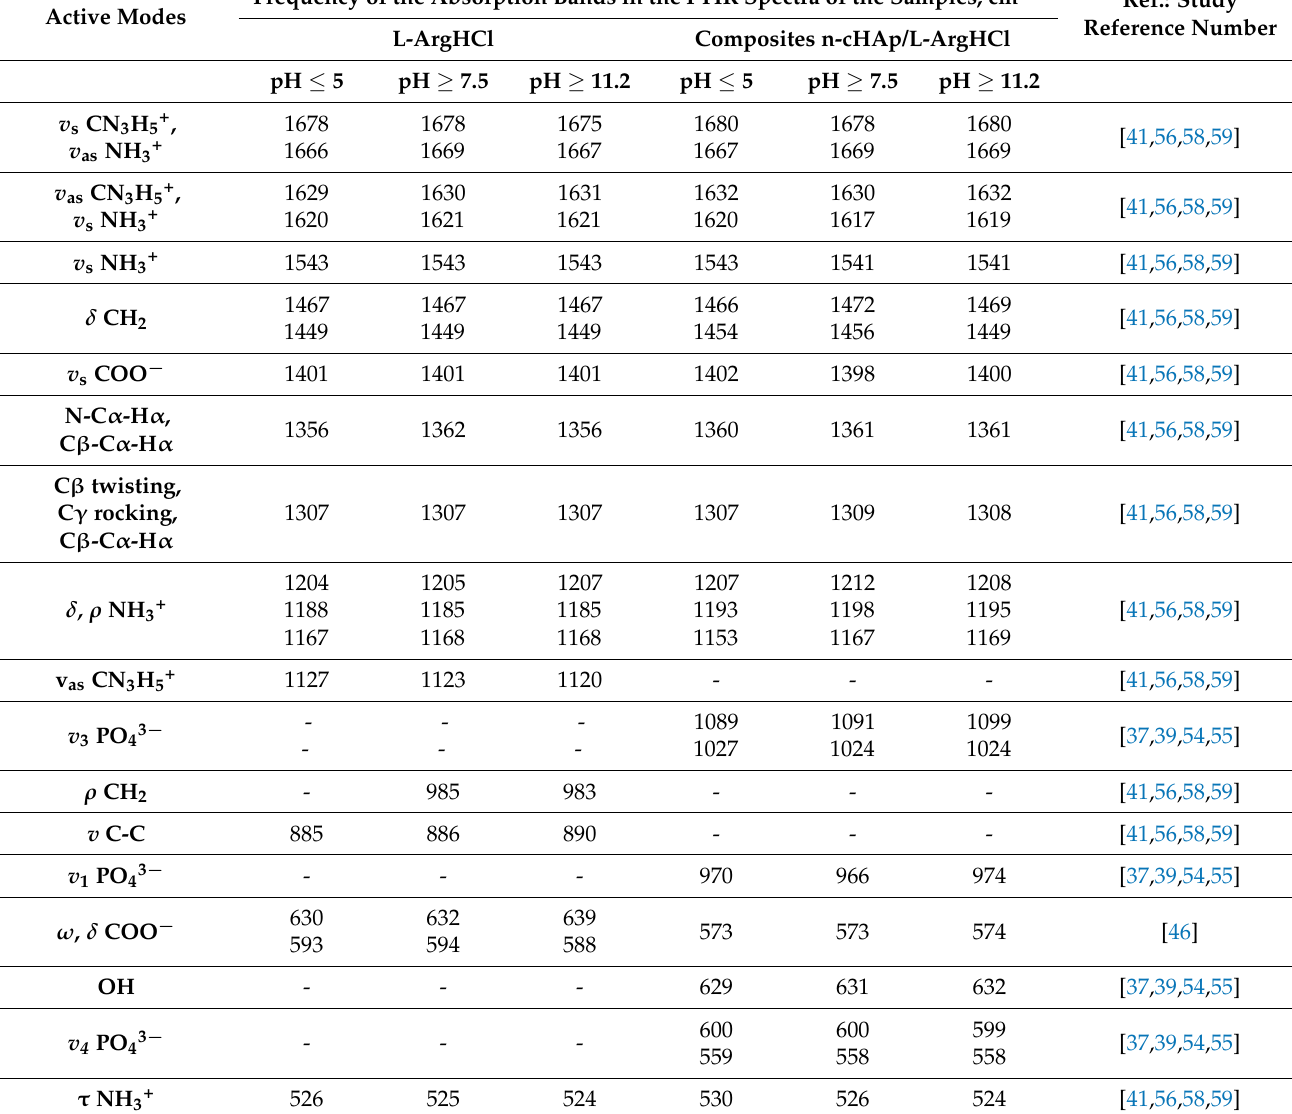
Frequency of the Absorption Bands in the FTIR Spectra of the Samples, cm − 1 Ref.: Active Modes